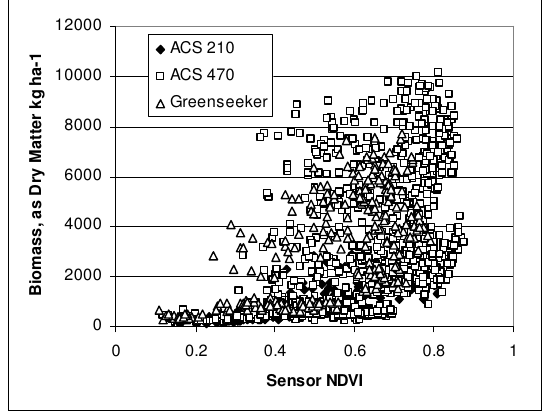
Figure 2. Above ground biomass measured as dry matter kg ha -1 plotted against the mean NDVI measured by plot for all data up to the flowering stage, Zadoks 60 (N=1475). The non linear equation fitted yield r 2 = 0.27 and a standard error of 2133 kg ha -1 .